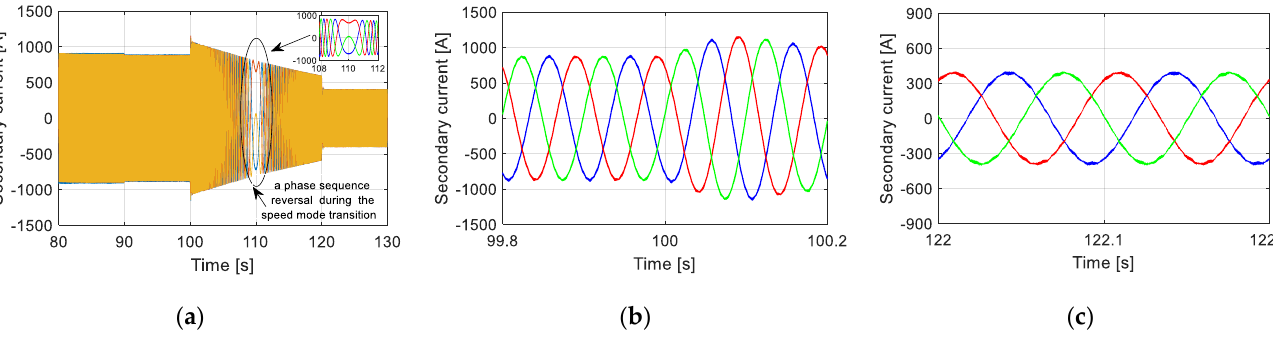
Figure 20. ( a ) Secondary current response, showing a phase sequence reversal while changing from super- to sub-synchronous speed modes ( Target IV ); ( b ) transient response of the secondary current; ( c ) steady state of the secondary current.